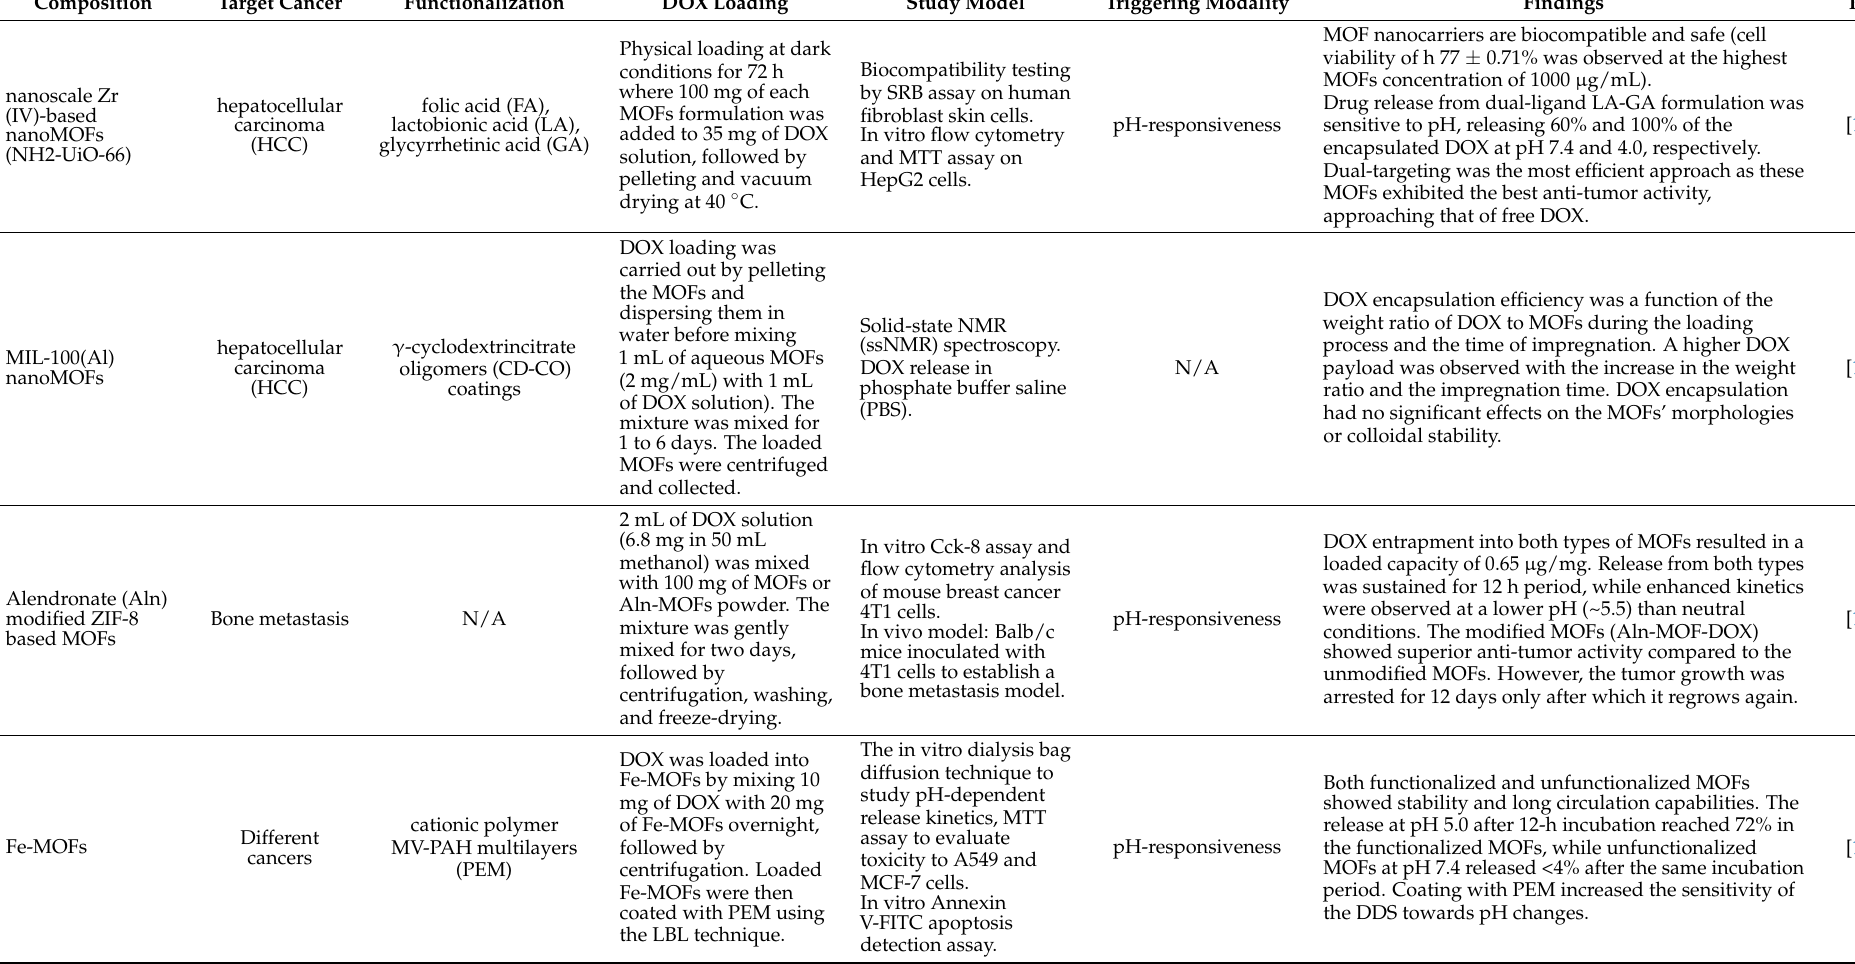
Table 5. Recent studies on MOF-based DDSs incorporating DOX for cancer